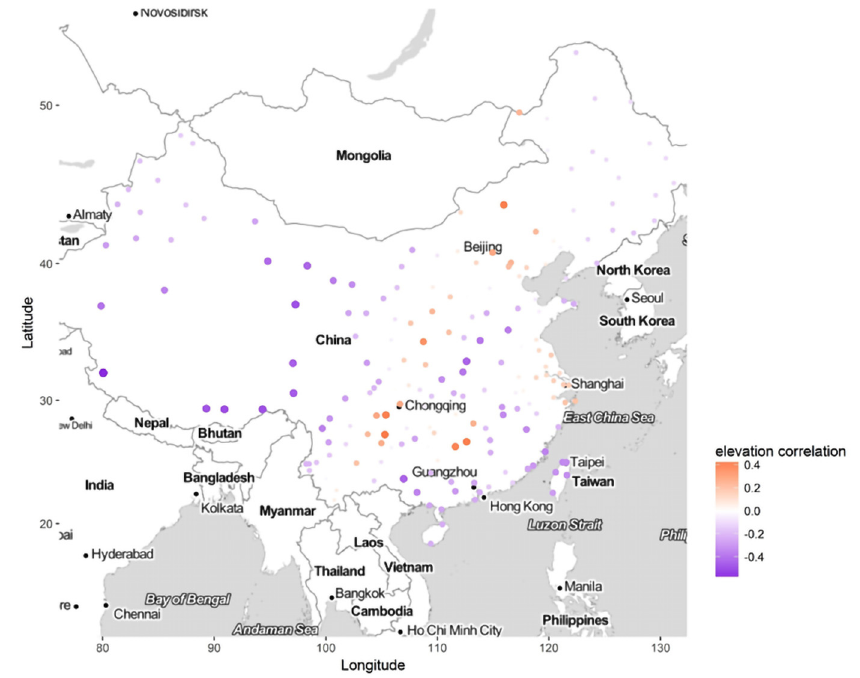
Figure 7. GWCCs between UA triggering frequency and elevation.